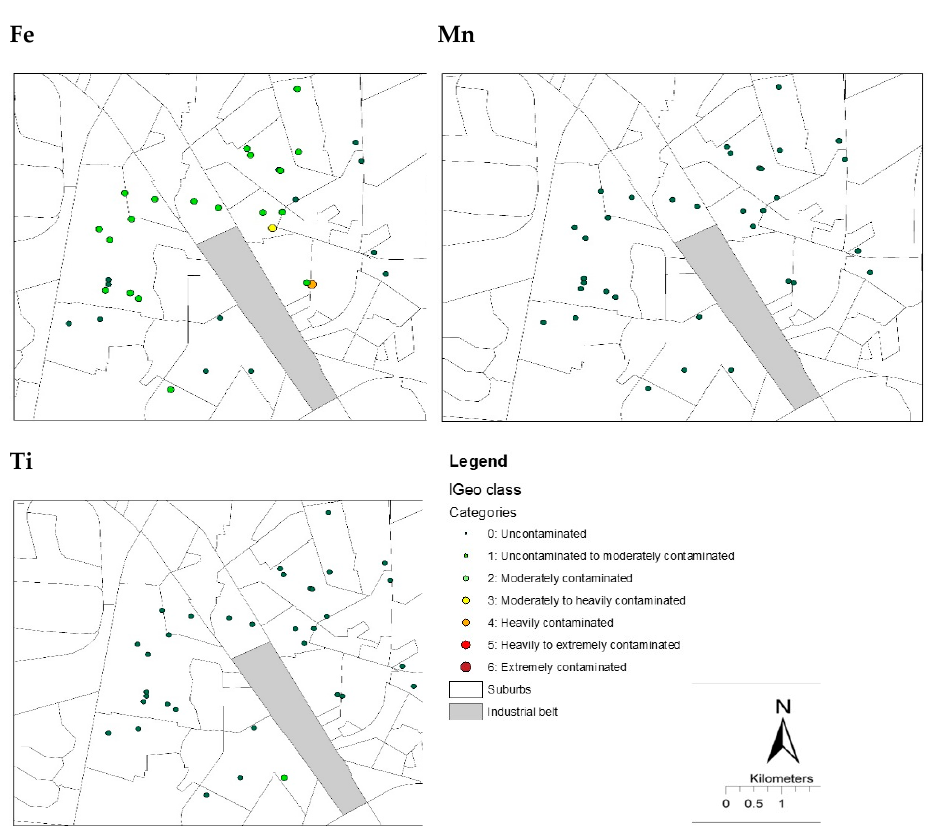
Figure 2. Geo-accumulation Index using mean levels of heavy metals in relation to the industrial zone. Source Identification Based on Factor Analysis